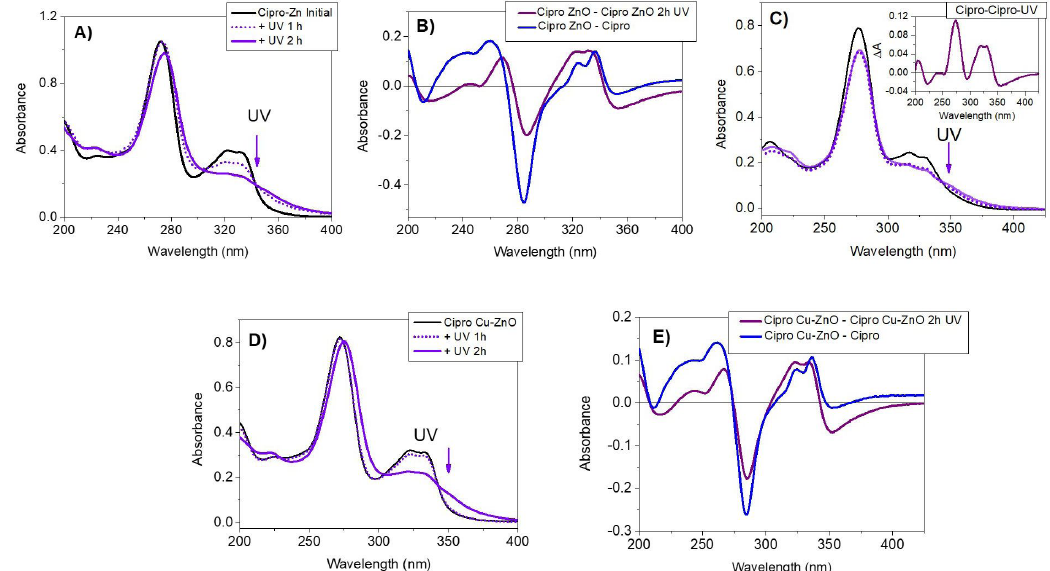
Figure 6. Photodegradation of CIPRO. A) Photobleaching of CIPRO-Zn complex obtained with ZnO and promoted by UV irradiation in two steps of 1 h as indicated by the arrow, B) Differential spectra obtained by subtracting CIPRO-Zn spectrum after 2 h of UV irradiation from the initial spectrum before irradiation (violet) and overlayed with the differential spectra of CIPRO-Zn minus CIPRO (blue). C) Photobleaching of CIPRO aqueous solution promoted by UV irradiation in two steps of 1 h as indicated by the arrow with the corresponding differential spectrum in the inset, D) Photobleaching of CIPRO-Zn complex obtained with Cu-ZnO and promoted by UV irradiation in two steps of 1 h as indicated by the arrow, E) Differential spectra obtained by subtracting CIPRO-Zn spectrum after 2 h of UV irradiation from the initial spectrum before irradiation (violet) and overlayed with the differential spectra of CIPRO-Zn minus CIPRO